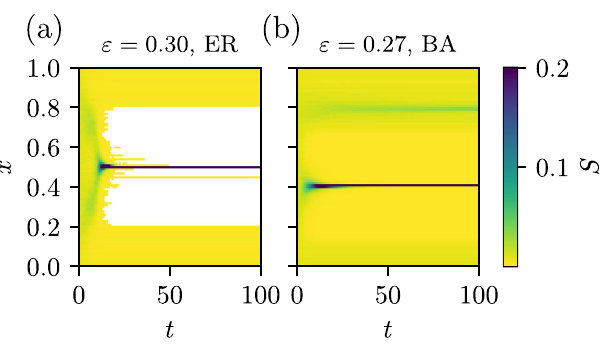
Fig. 5 Comparison of single sample trajectories near the transition, for Erd ő s – Rényi and Barabasi – Albert hypergraphs. Examples of the trajectory of a single realizations of the HOID model of size N = 16,384 and edge size k = 3, close to their transition to consensus. a ER hypergraph with connectivity c = 10. b BA hypergraph with c = 9. The horizontal axis is time in units of sweeps, i.e., N attempted updates. The dark colours show regions where agents are highly concentrated, light colour show regions with only very few agents and white signi fi es the absence of any agents. The colourmap is truncated at S = 0.2, to better visualize the small clusters, therefore the darkest shade represents all values 0.2 ≤ S ≤